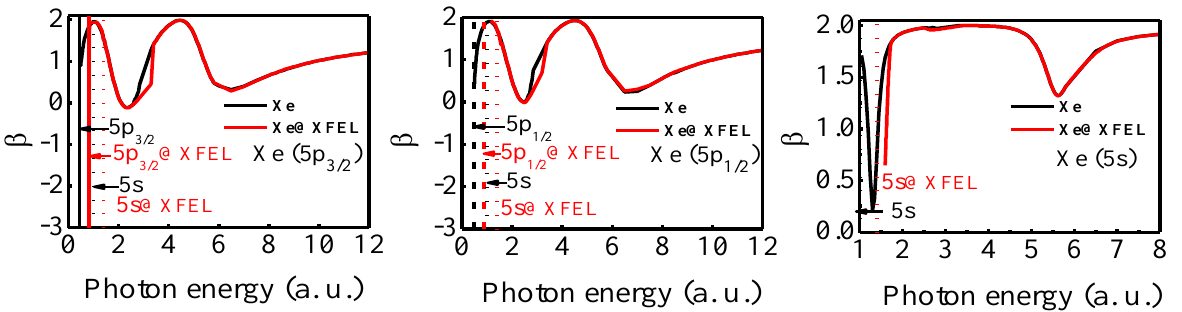
Figure 15. Photoionization cross section (σ) of 5p 3/2 (Left), 5p 1/2 (Middle), and 5s (Right) subshells of Xe (black) and Xe@XFEL (red). Solid, dashed, and dotted vertical lines represent the threshold for 5p 3/2 , 5p 1/2 , and 5s thresholds of free (black) and confined atom (red), respectively.